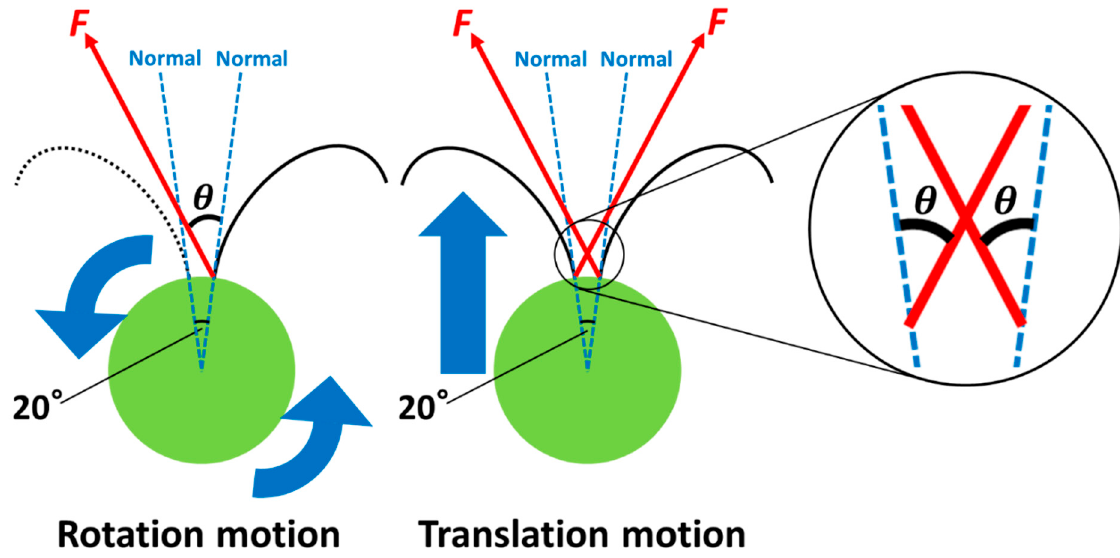
Figure 14. Schematic diagram of the translation and rotation motion of C. reinhardtii.